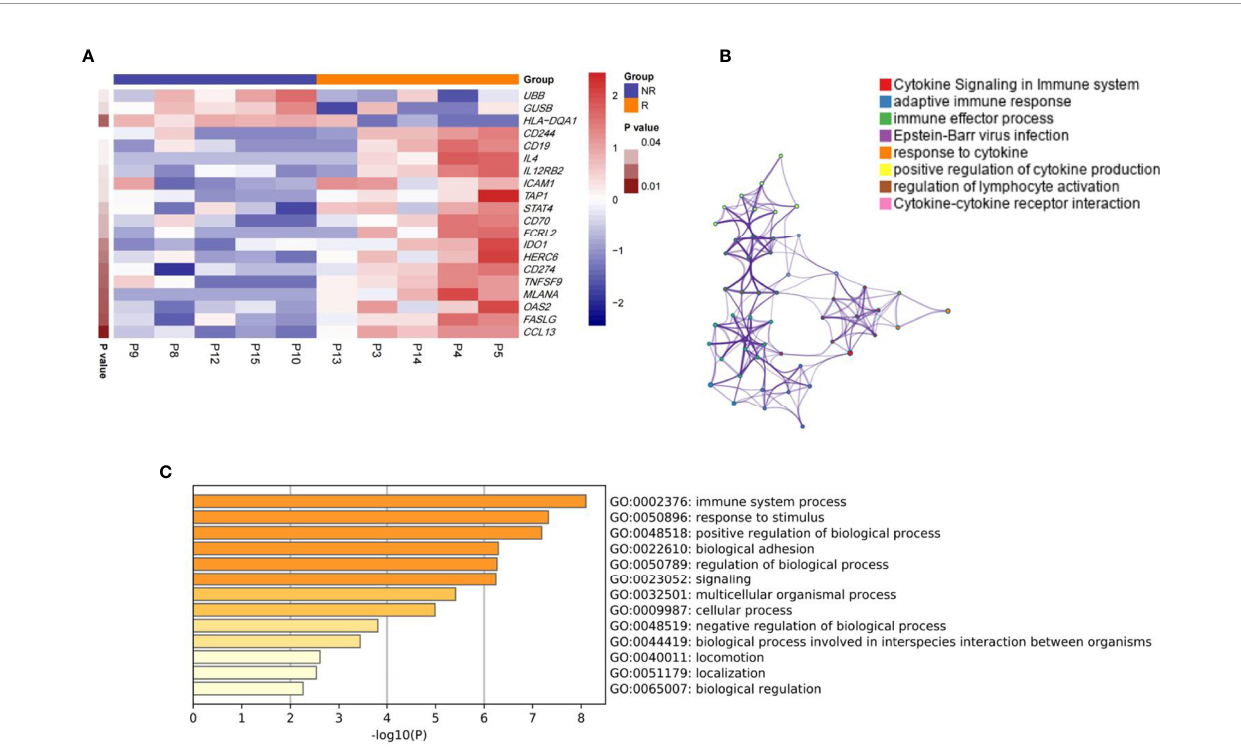
FIGURE 1 | GUSB was signi fi cantly upregulated in anti-PD1 non-responding tumors compared with responding tumors in HCC patients (A) 10 HCC patients were treated with anti-PD1, and the biopsy samples before treatment were used for 289 nanostring panel RNA sequencing to compare responding ( ≥ 50% tumor necrosis) (R) and non-responding tumors (<50% tumor necrosis) (NR). Panel (A) is presented in the form of a heatmap. (B, C) Pathway analysis showing the different genes ’ enrichment. Panel (B) is presented as a mesh graph and Panel (C) as a bar